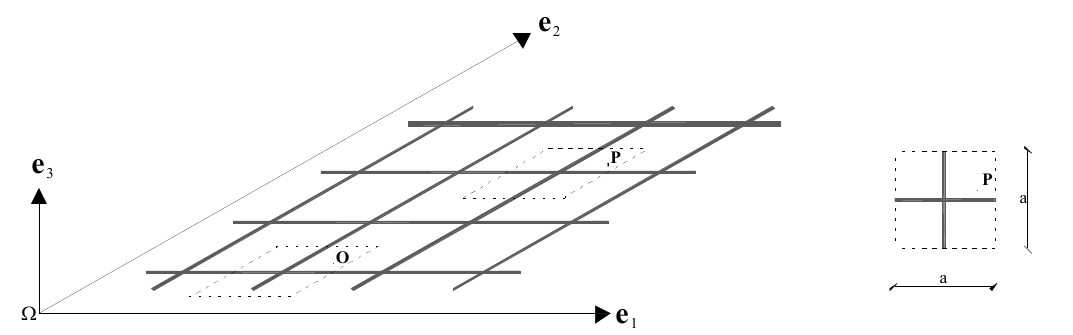
Figure 1. Example of two-dimensional (2D) square lattice